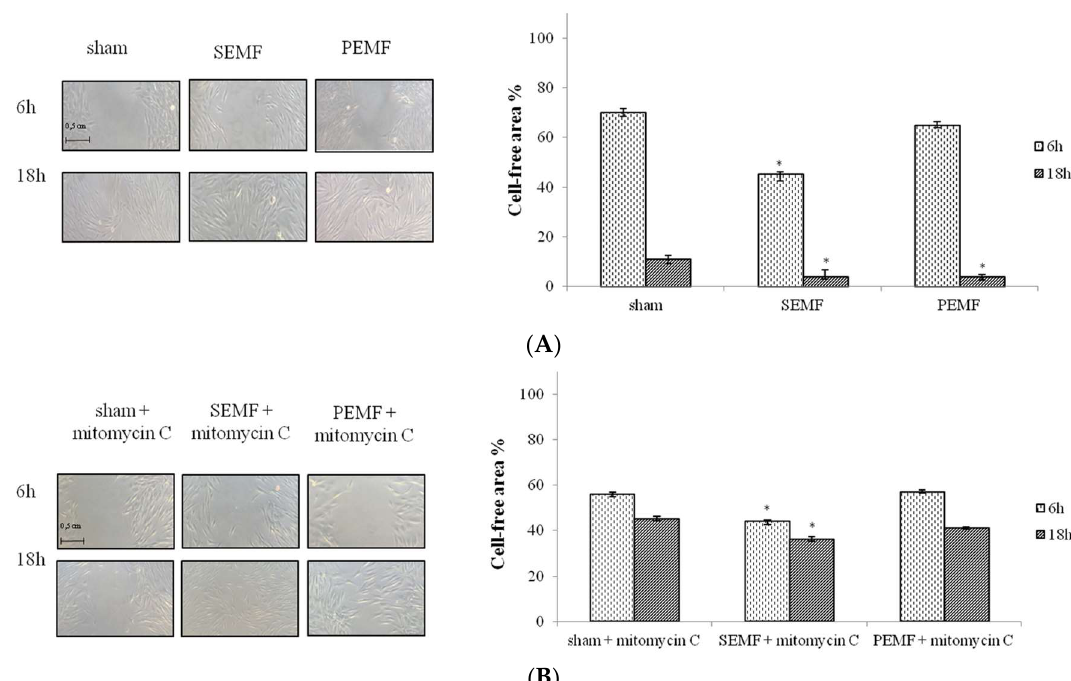
Figure 3. Representative light-microscope images of wound-healing assays for hGFs. ( A ) Cell migration rate was evaluated after 6 and 18 h of exposure to sham, SEMF, and PEMF. ( B ) Cell migration rate was evaluated after the exposure of mitomycin C pre-treated cells to sham, SEMF, and PEMF for 6 and 18 h. Scratch width was determined from images taken after both exposure times by measuring the distance between the two points with maximal distance on the outer edges of the cells. The average width of each scratch was calculated as a percentage of the original scratch width. The graph represents the cell migration e ffi ciency, measured as the change in cell-free area over-time, assuming the width of the fresh wound was equal to 100%. The original microscope magnification was 10 × . Scale bar = 0.5 cm. * p -Value ≤ 0.05 SEMF vs. sham and PEMF vs. sham.